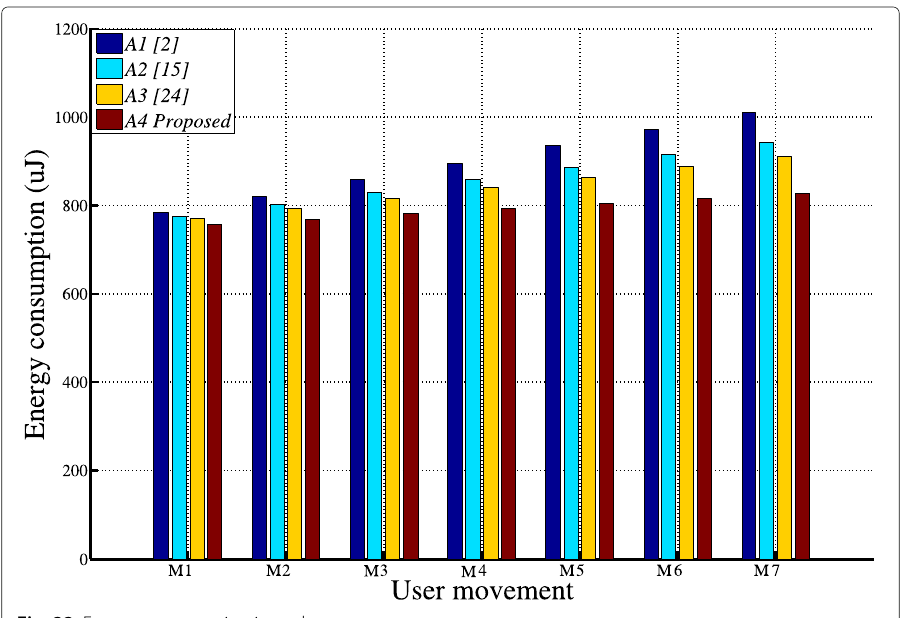
Fig. 22 Energy consumption in each user